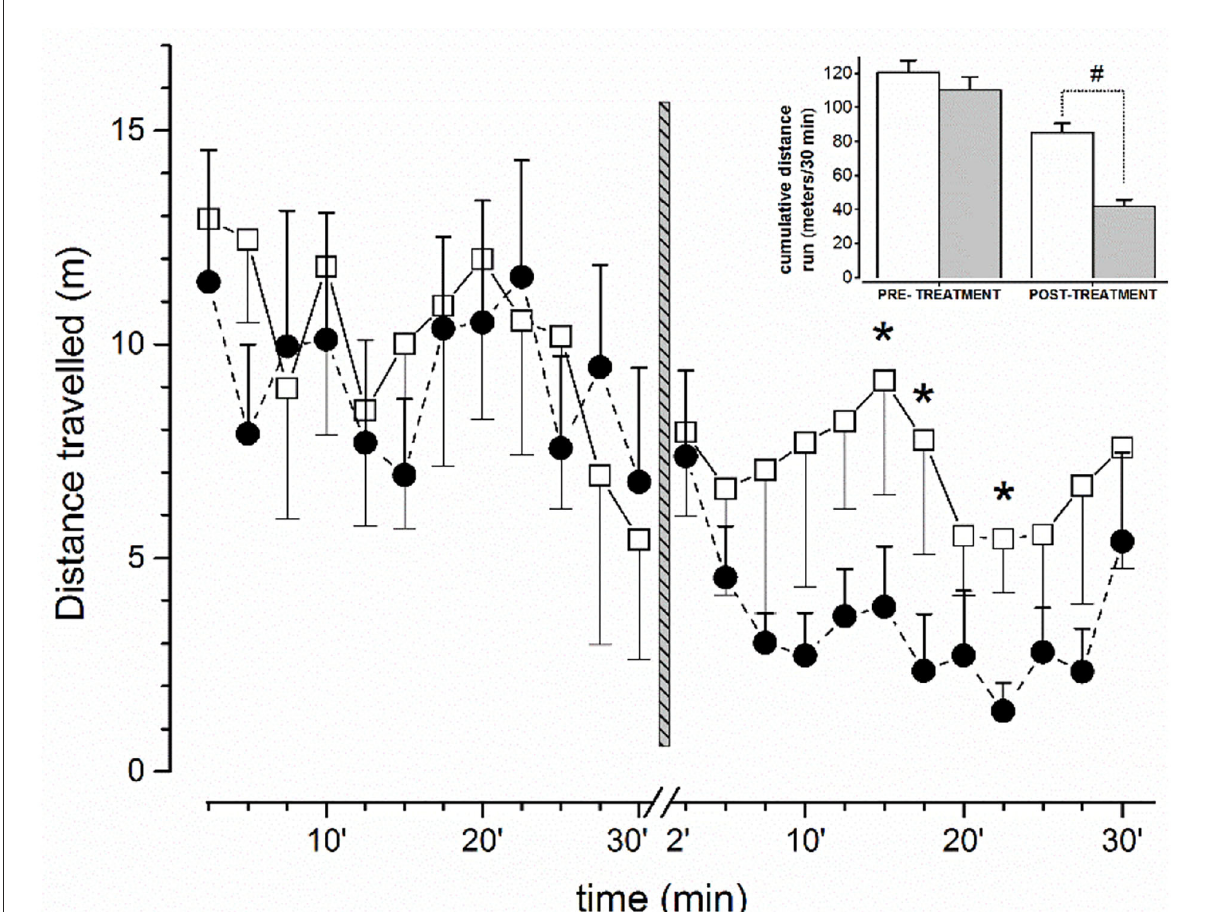
FIGURE1 Effect on free locomotor activity of mice before and after administration of vehicle or JWH-073 1 mg/kg. Data compare the average (meter/150s) distance run before/after vehicle ( (cid:3) , n = 5) or JWH-073 ( • , n = 9) (2.5 min/point). Treatment administration instant corresponds to vertical bar (time 0, middle figure). First 2min after administration were not recorded. Distance run decreases approximately constantly before treatment and diverges soon after. Inset: Histograms representing cumulative distance run before and after substance administration (White = vehicle; gray = JWH-073). Statistical analysis was performed with t-Student test for unpaired data. * p < 0.05, # p < 0.01, vs.